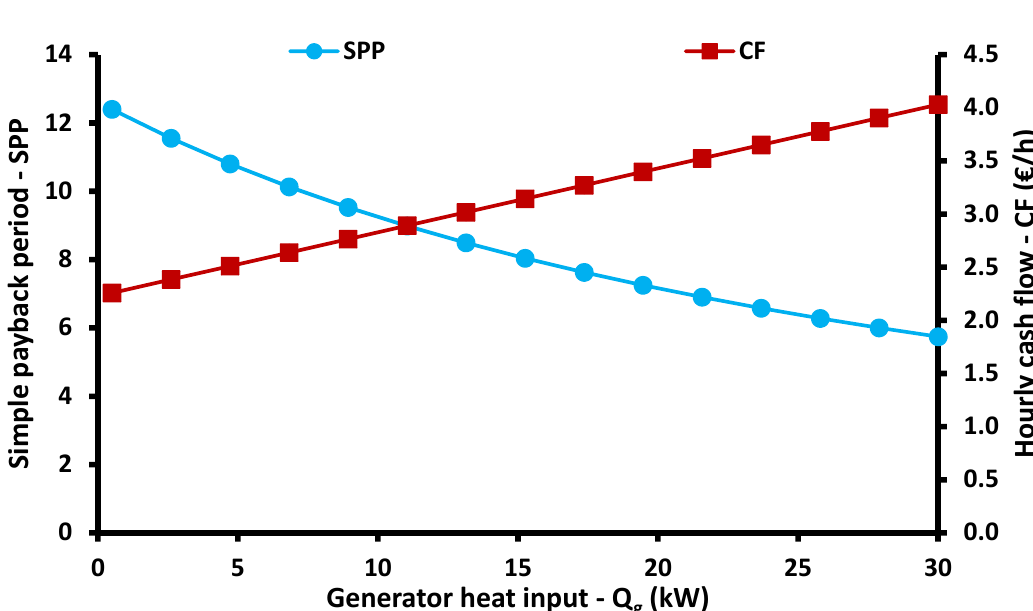
Figure 13. Simple payback period and hourly cash flow for different generator heat input values.